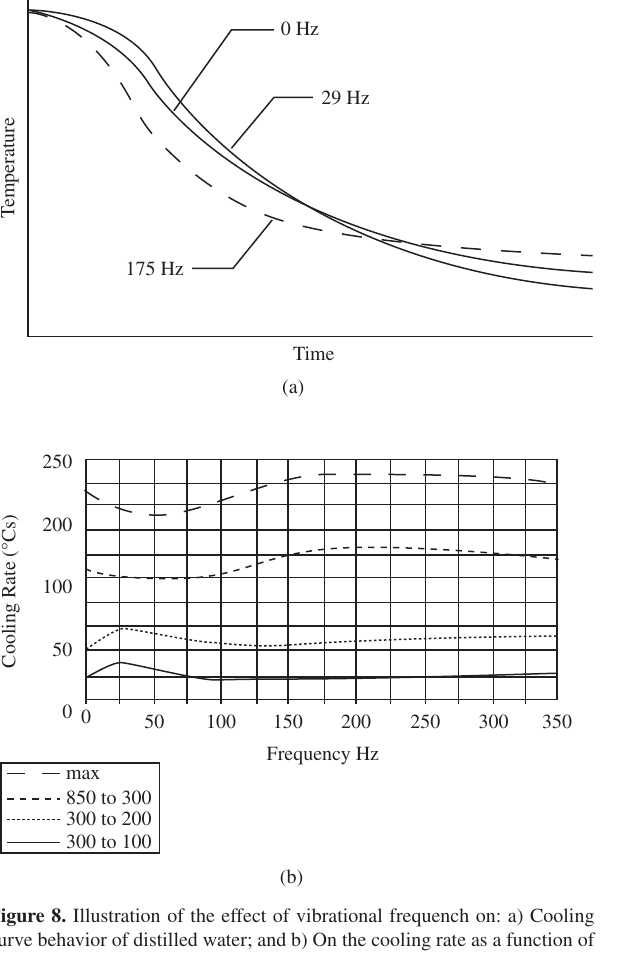
Figure 8. Illustration of the effect of vibrational frequench on: a) Cooling curve behavior of distilled water; and b) On the cooling rate as a function of vibrational frequency.